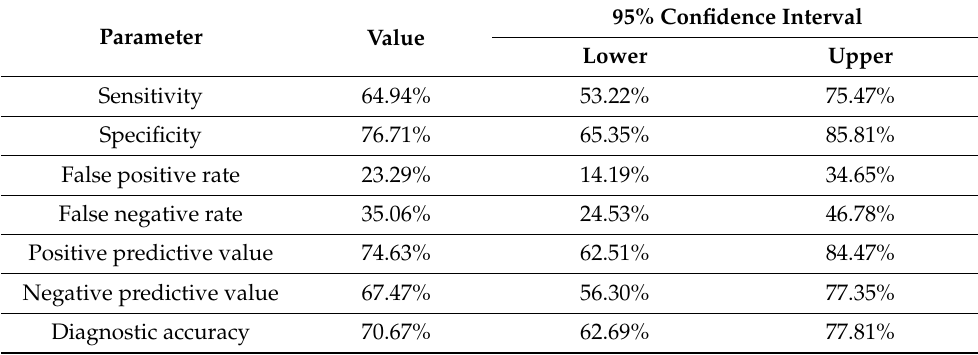
Table 6. Validity of C-Reactive Protein in predicting Tuberculosis (with a CRP cut-off value of 10